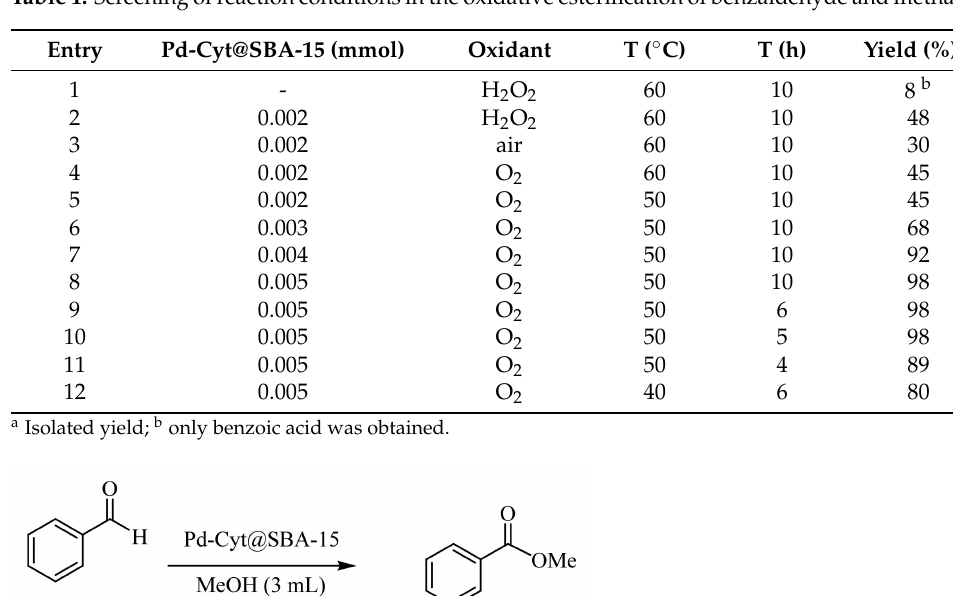
Table 1. Screening of reaction conditions in the oxidative esterification of benzaldehyde and